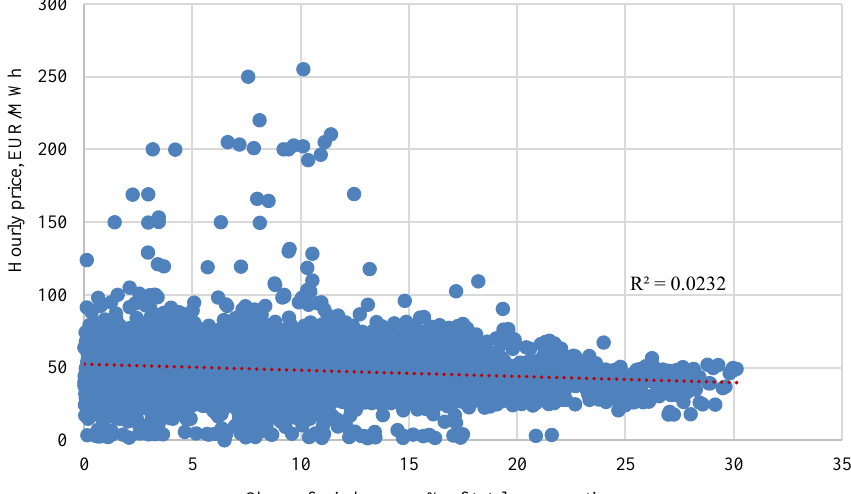
Fig. 3. Correlation between wind power production and power market price on hourly basis in Denmark during 2019 (Data source: Nord Pool Spot).